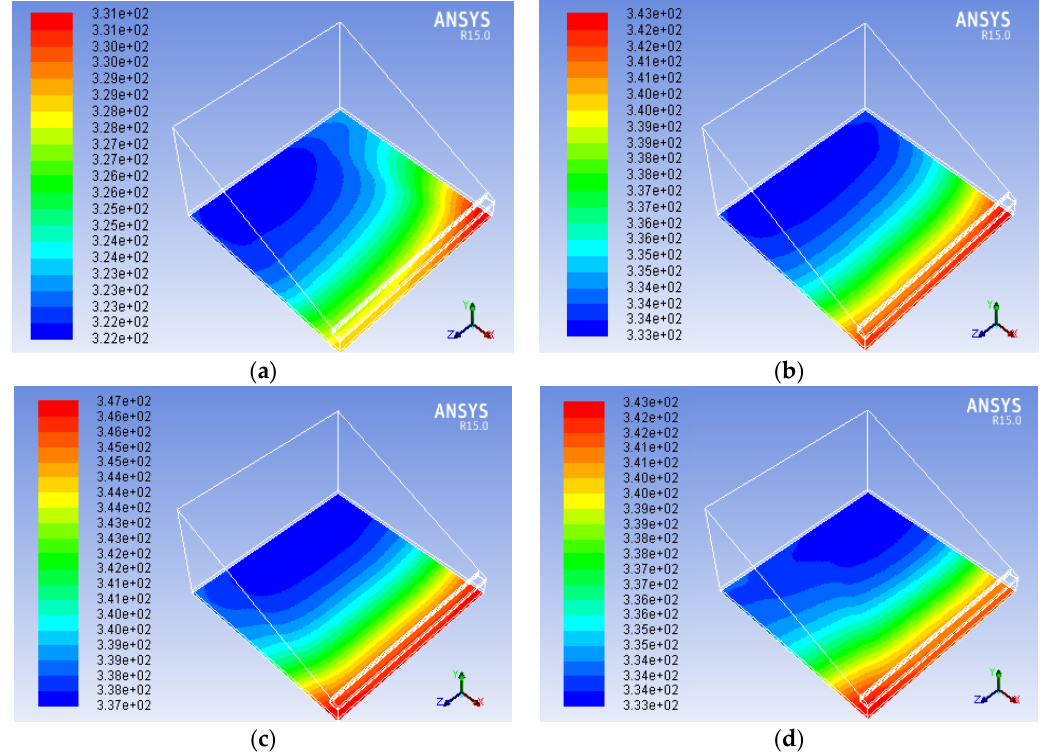
Figure 8. The temperature contours of the absorber plate at different time intervals with a water depth of 2 cm. ( a ) Contour of temperature at 10:00, ( b ) contour of temperature at 12:00, ( c ) contour of temperature at 14:00, ( d ) contour of temperature at 16:00.